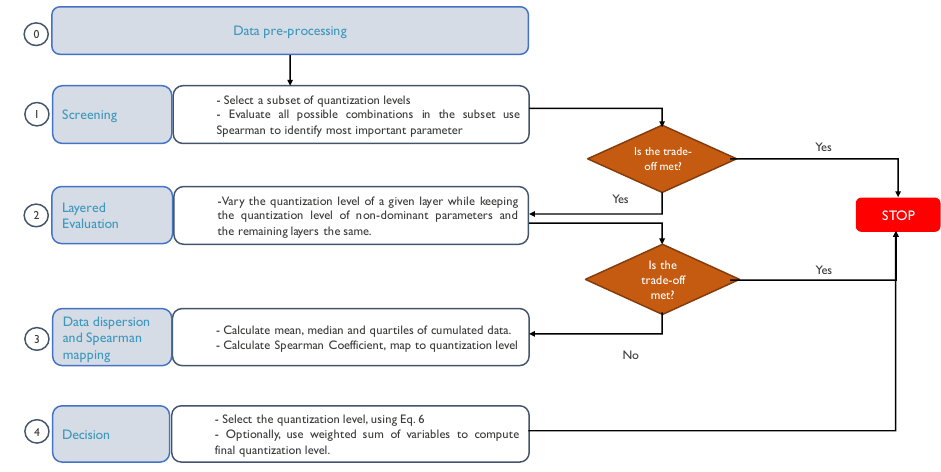
Figure 3. Proposed methodology based on fractional factorial